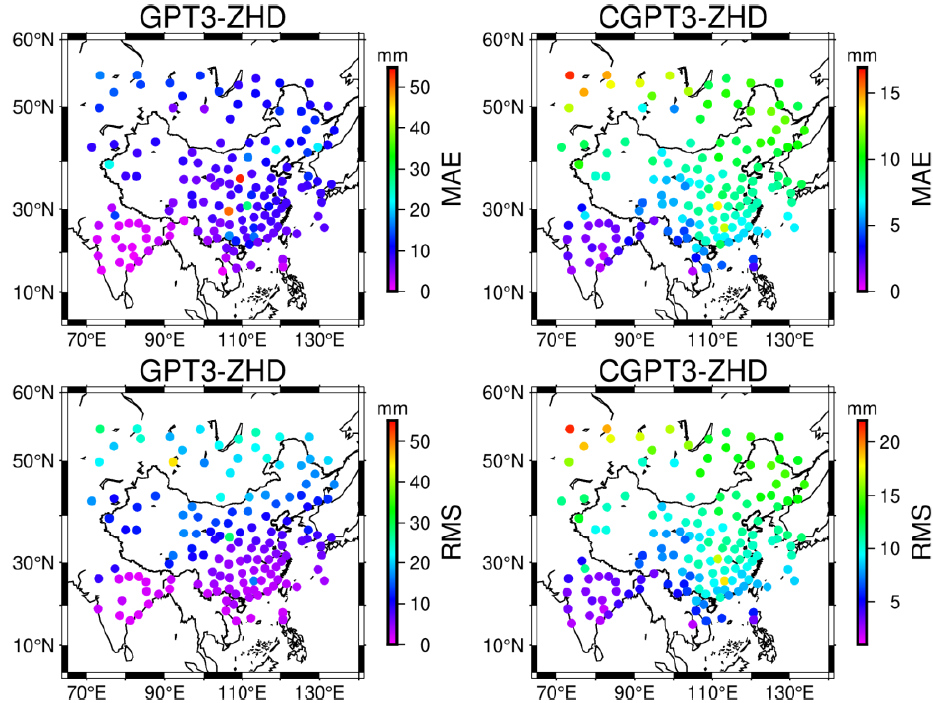
Figure 4. Distribution of MAE and RMS from the ZHD derived from GPT3 and CGPT3 models validated by modeling data ( left — GPT3, right — CGPT3).